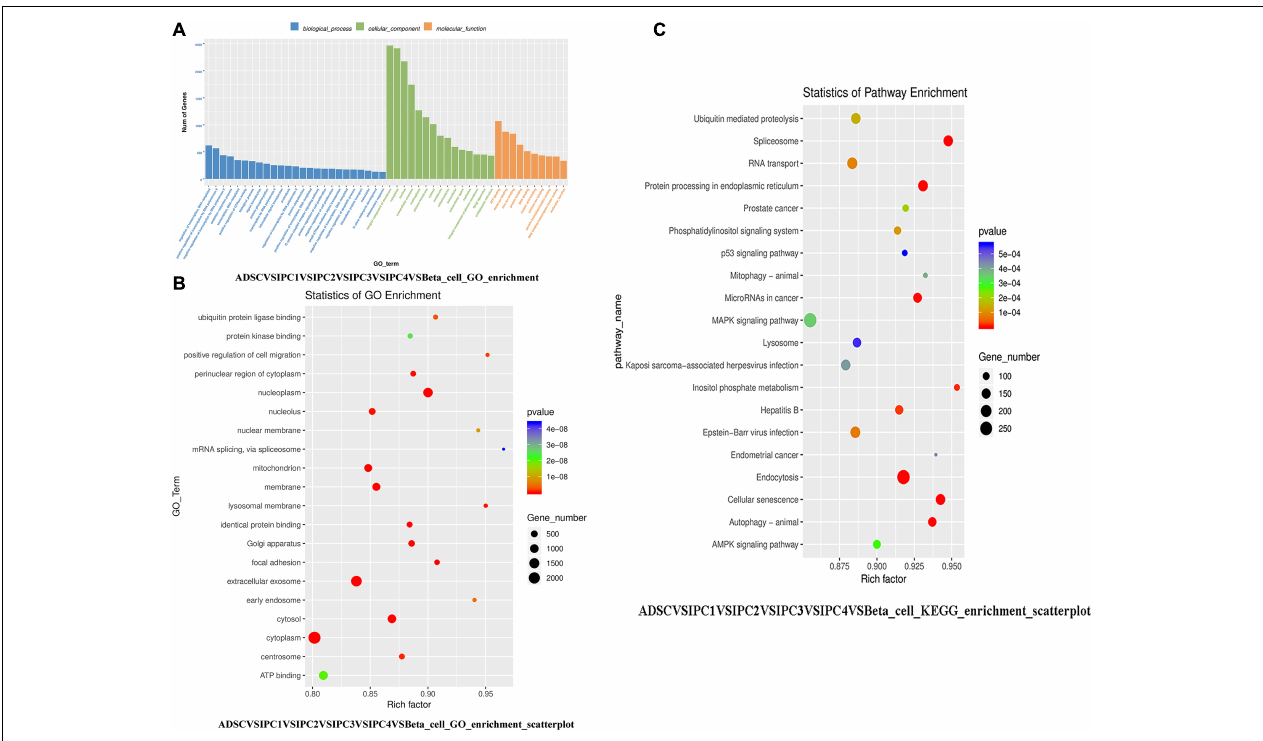
FIGURE 5 | The GO functional enrichment analysis and KEGG pathways enrichment analysis. (A) The GO enrichment analysis of all DEGs. (B) The 20 most significant GO terms in GO functional enrichment analysis of DEGs. The horizontal axis represents the enrichment degree (Rich factor), the vertical axis represents the GO Term of enrichment. Dot size indicates the number of DEGs enriched in a GO term. The dot color represents different P -values; Rich factor means the number of DEGs belonging to a certain GO term. The higher the Rich factor is, the higher the GO enrichment degree will be. (C) The 20 most significant KEGG pathways in KEGG Pathways Enrichment Analysis of